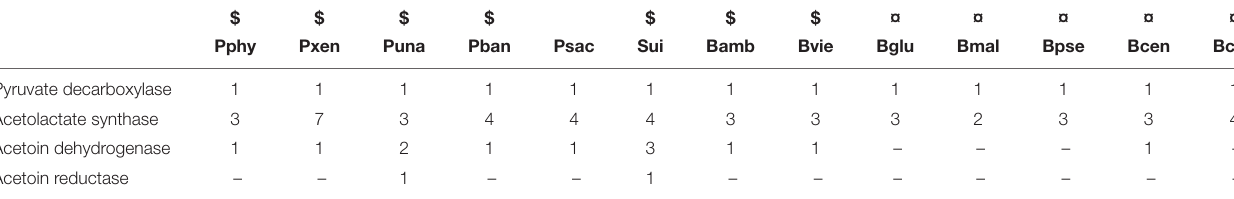
TABLE 4 | Key enzymes involved in biosynthesis of volatile organic compounds acetoin and 2,3-butanediol. $